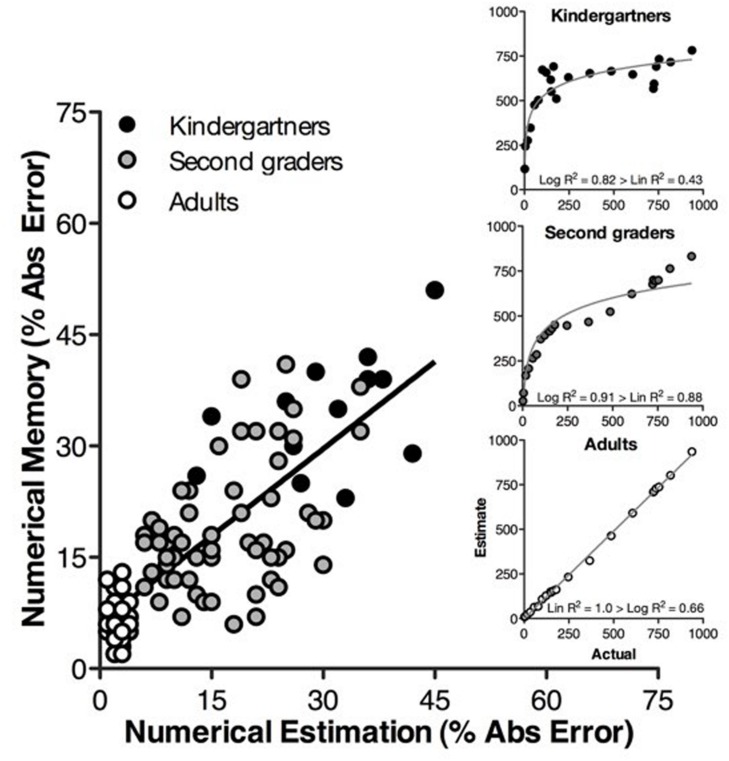
Percent absolute error (PAE) on the numerical estimation task is strongly correlated with PAE on the numerical memory task for Kindergartners (black circles), second graders (gray circles), and adults (white circles). The inset figures illustrate a logarithmic-to-linear shift in numerical estimation across the age range.